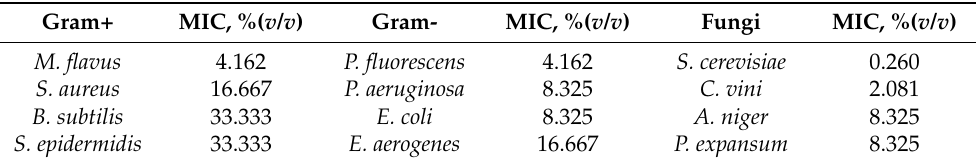
Table 5. Minimal inhibitory concentrations of the ethanol extract of T. baicalensi determined by the microdilution